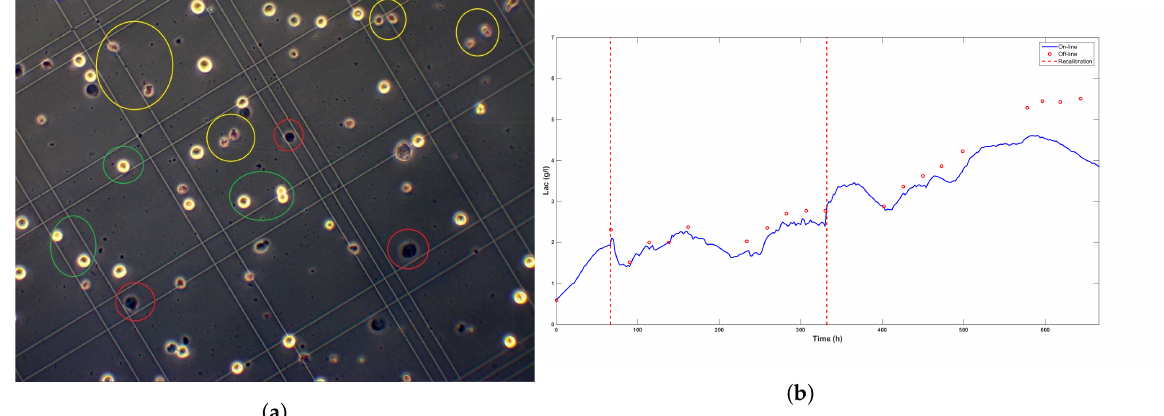
Figure 7. Picture of the Bürker plate taken with an electronic microscope about 100 h after the ATF controller change ( a ) and the evolution of the lactate concentration ( b ). Even though online signals drift apart from the off-line measurements after 500h, no calibration is performed due to increasing biomass death rate and the expected culture